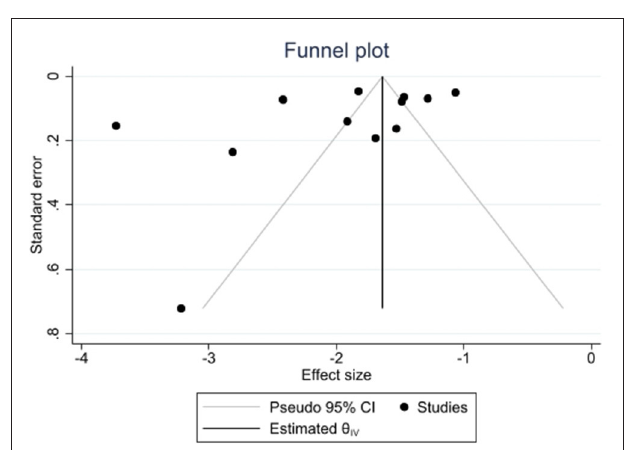
FIGURE 4 | Funnel